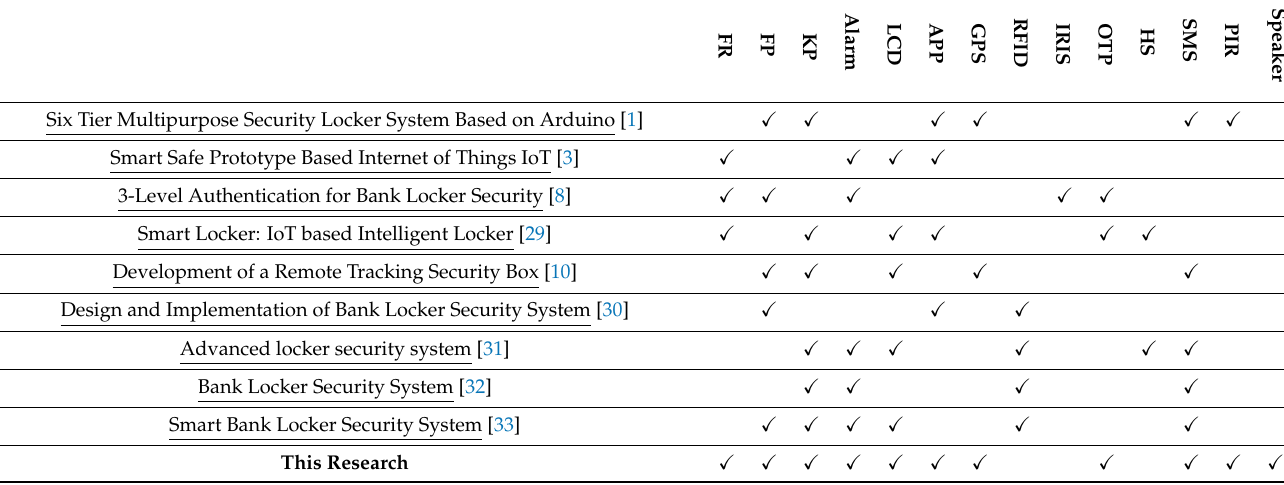
Table 1. A comparative analysis of the existing